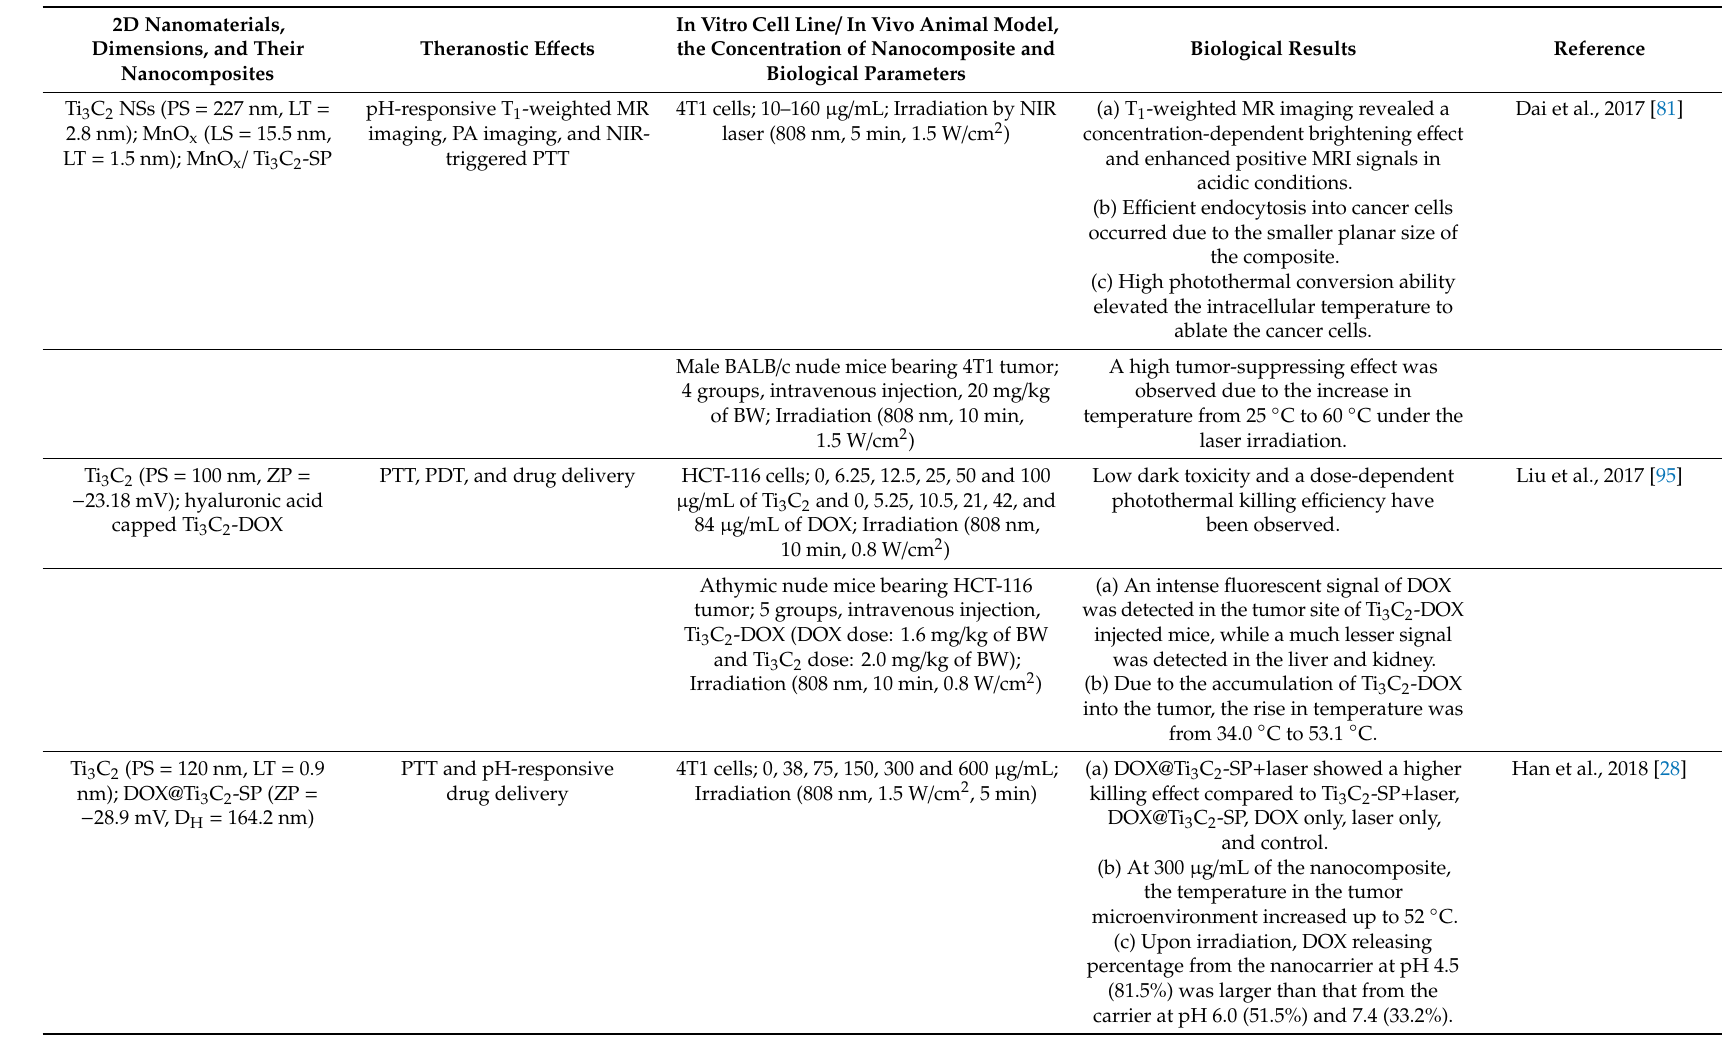
Table 1. Published in vitro and in vivo cancer treatment studies involving 2D theranostic nanomaterials. 2D Nanomaterials, Dimensions, and